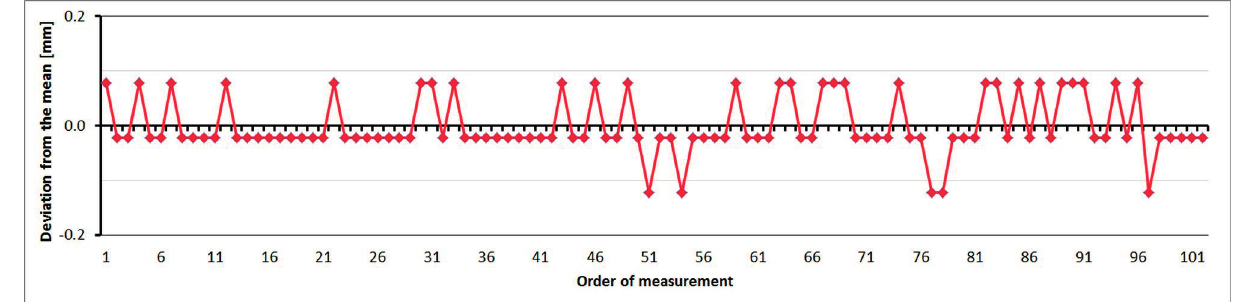
Figure 23. Leica TC2003–Differences from average distance–pillar 7 (13.9